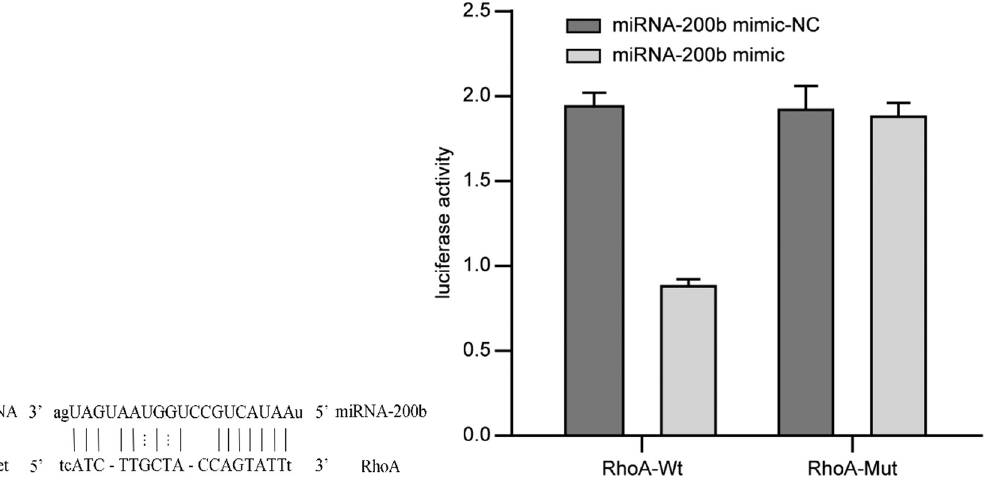
Figure 2: Conservative analysis of miRNA - 200b binding sites and activity analysis of luciferase. Note: compared with mimic - NC group, * P < 0.05.